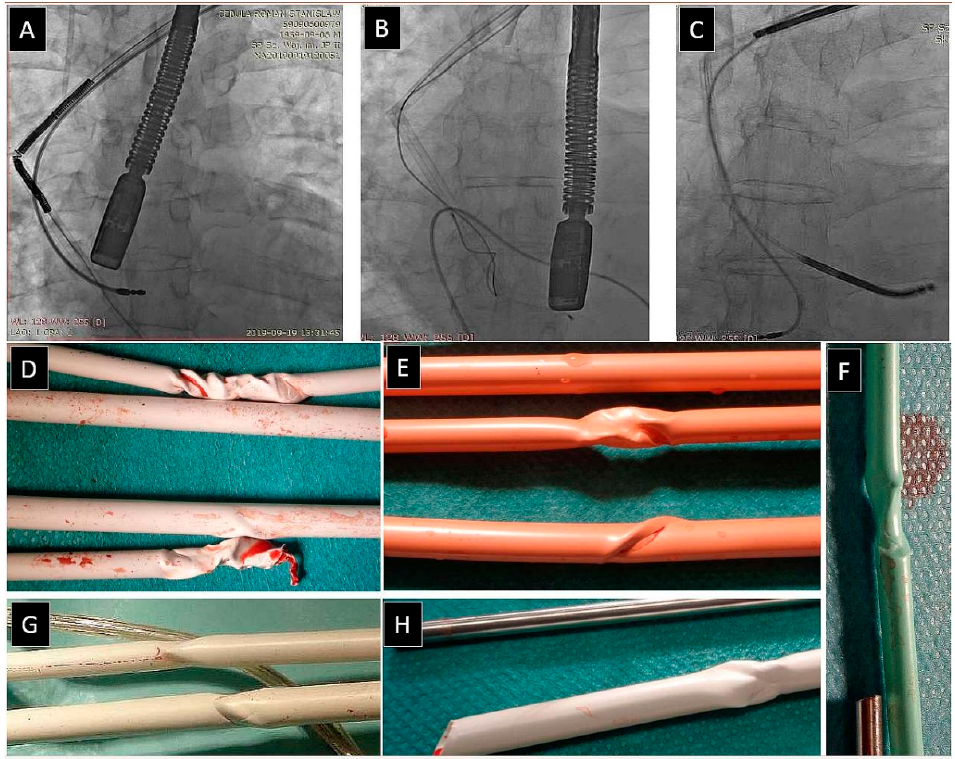
Figure 1. Byrd dilator collapse/fracture. Polypropylene catheter kinking is not a problem if detected early ( A – C ). Each successive rotation of the kinked polypropylene catheter rolls it up and tightens on the lead ( E – H ), making it more and more difficult to remove ( D ). Good quality fluoroscopy and careful observation of the entire working catheter can prevent secondary major problems